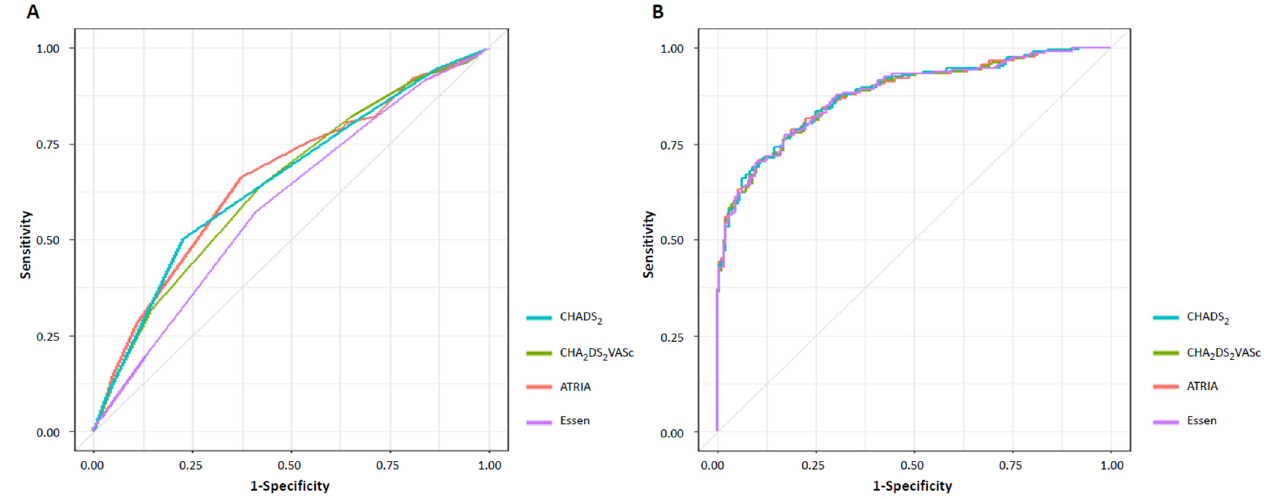
Figure 2. Receiver operating characteristic curve analyses of unfavorable outcomes based on stroke risk scores. ( A ) Univariable ROC analysis, ( B ) multivariable ROC analysis. ROC, receiver operating characteristic.